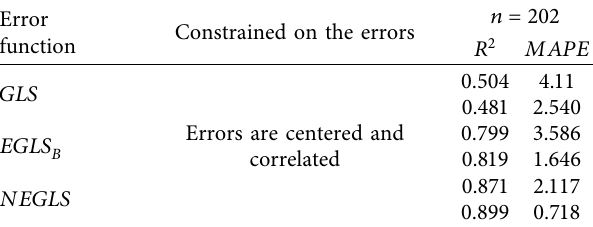
Table 2: Comparison of statistical performances of quadratic error functions with imprecise real